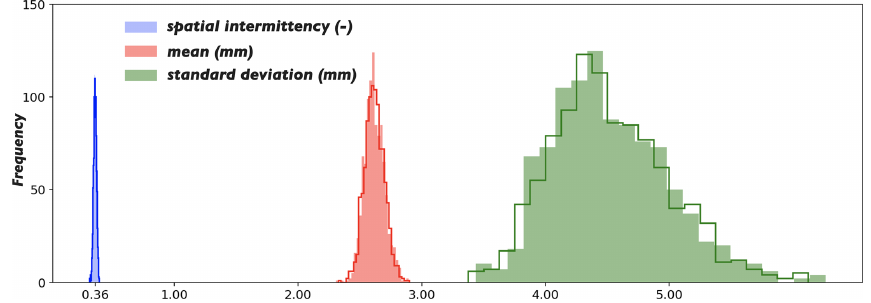
Figure 4. The coloured histograms were evaluated from the 1000 true rainfall fields. The unfilled histograms overlaid on the coloured ones were evaluated from the 1000 rainfall fields that contain random error only (SNR = 3).